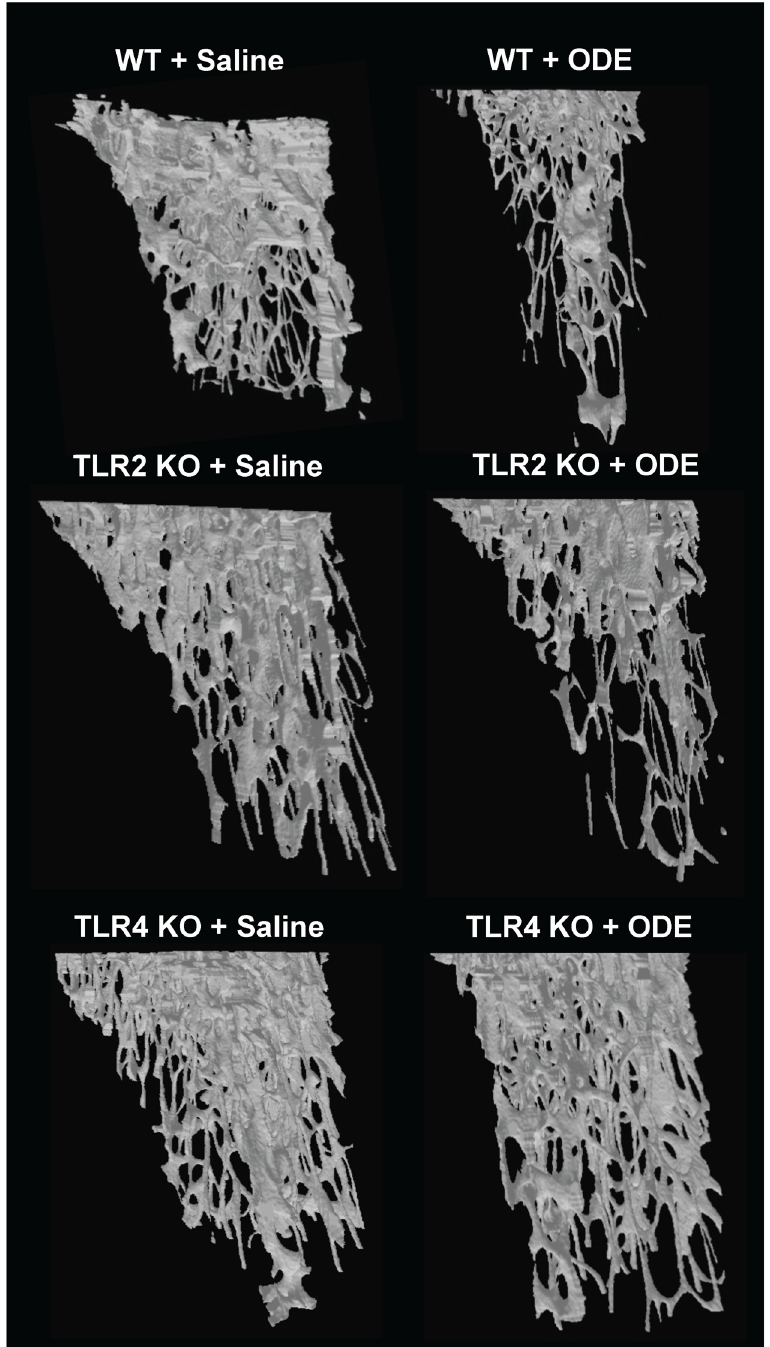
Fig 4. Loss of trabecular bone demonstrated in WT and TLR2 KO, but not TLR4 KO, mice treated repetitively with inhalant ODE. WT, TLR2 KO, and TLR4 KO animals were i . n . treated daily with saline or ODE for 3 weeks. A representative three-dimensional (3D) reconstructed image from region of interest of proximal tibia from one mouse per treatment group (minimum of 6 mice/group from 3 independent studies).